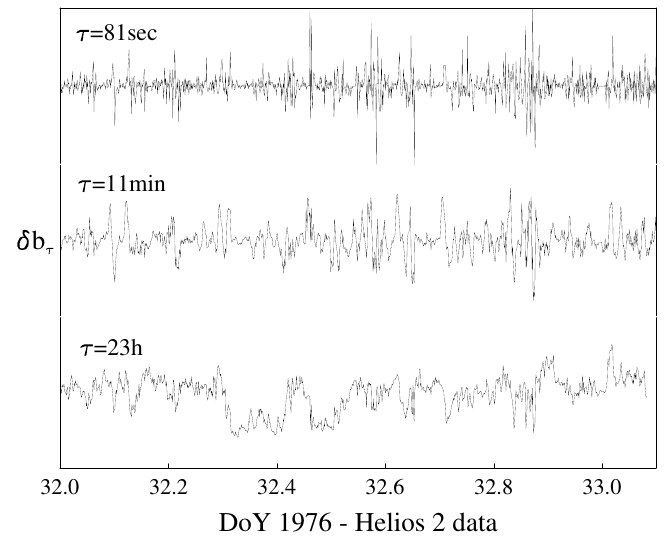
Figure 86: Differences for the magnetic intensity Δ 𝑏 𝜏 = 𝐵 ( 𝑡 + 𝜏 ) − 𝐵 ( 𝑡 ) at three different scales 𝜏 , as shown in the